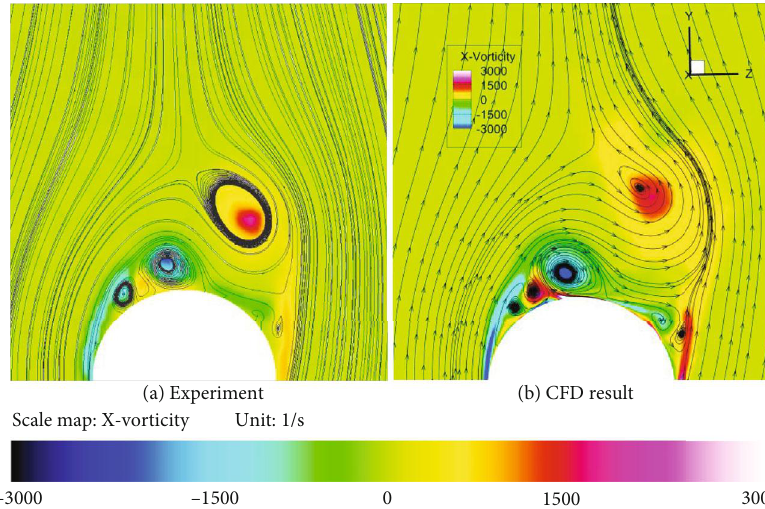
Figure 17: Comparison contour of experimental and numerical simulation results for surface roughness R a = 0 : 8 μ m at section 3.